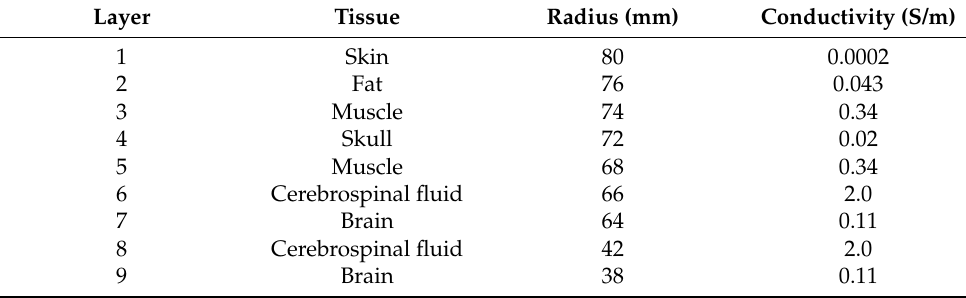
Table 1. Multilayered sphere